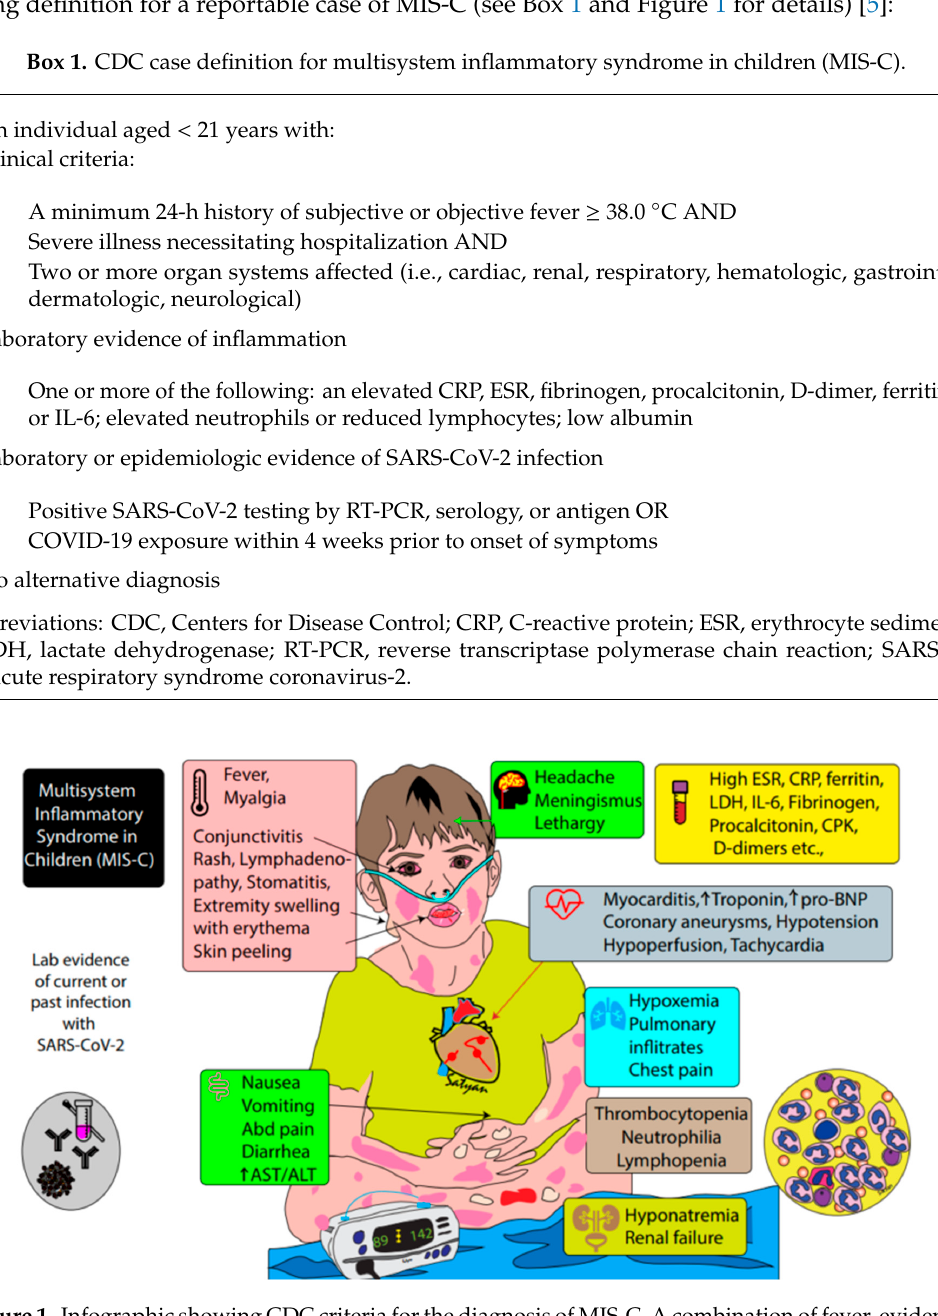
Figure 1. Infographic showing CDC criteria for the diagnosis of MIS-C. A combination of fever, evidence of inflammation, involvement of at least two organ systems, and prior evidence of SARS-CoV-2 infection are required to establish the diagnosis.